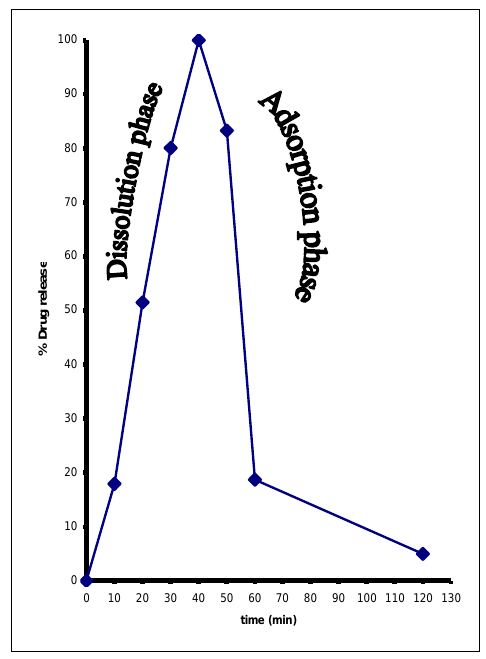
Figure 11: The percent of alpha-tocopherol acetate released from adsorbents mixture of microcrystalline cellulose and magnesium carbonate at pH 1.2 after 3 months of incubation period.